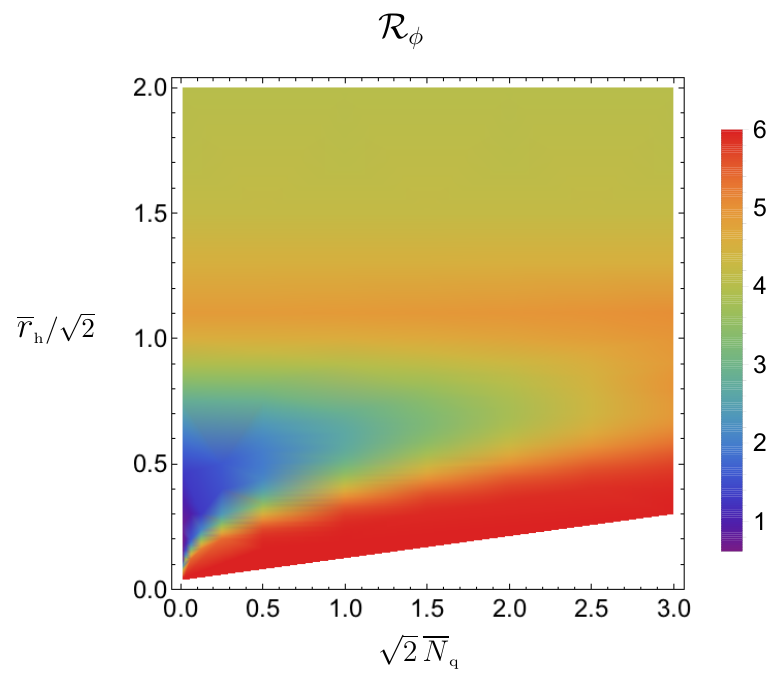
Figure 11. Dilaton scaling R (cid:30) as de(cid:12)ned in eq. (3.16)